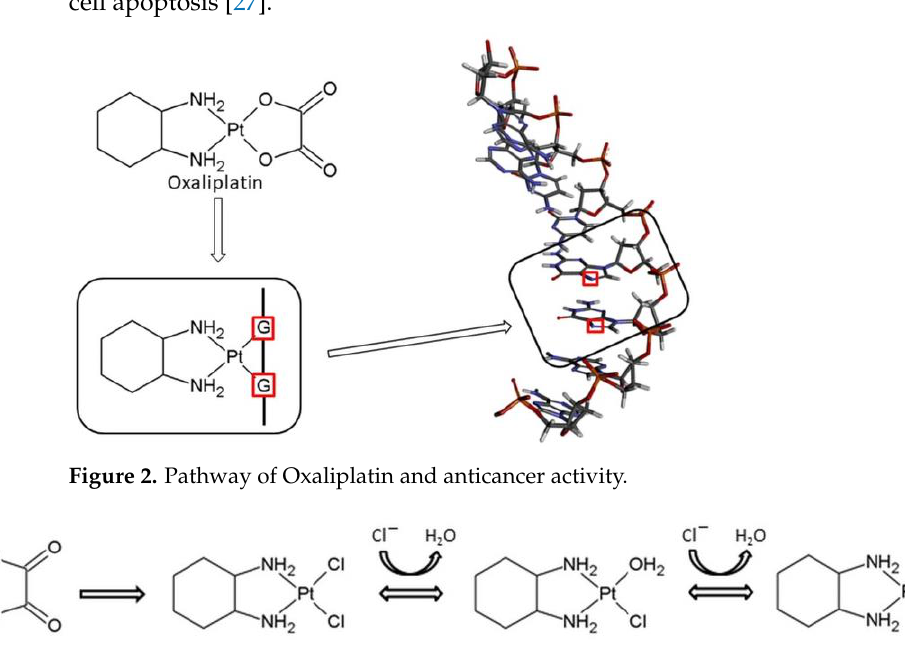
Figure 3. Biotransformation pathway of Oxaliplatin.